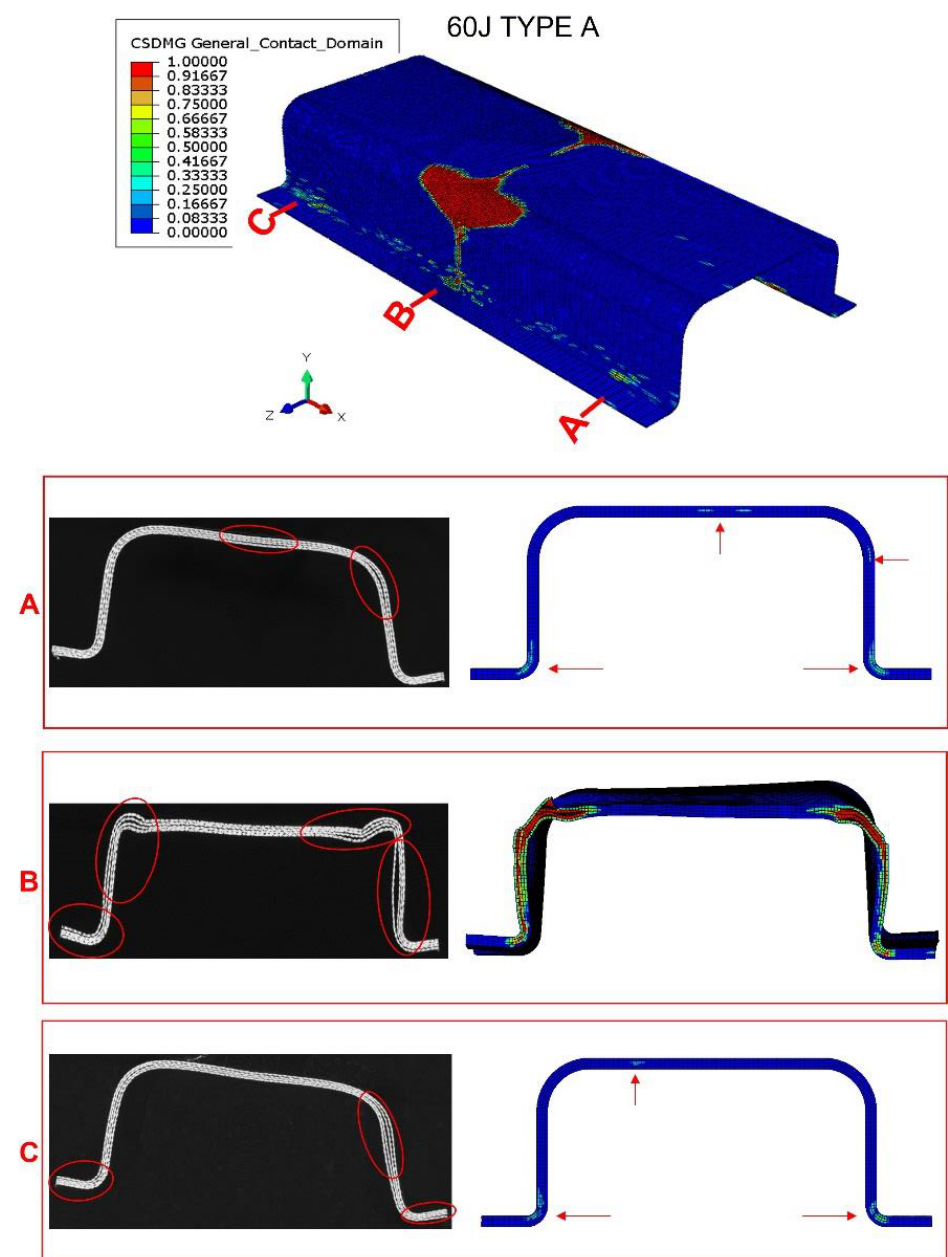
Figure 10. Tomography of bumper beam type A, impact energy of 60 J; comparison with numerical results. Observation of the interlaminar failure in the ends of the beam (sections A and C) and the center of impact (section B). The red arrows in the numerical screenshot point the appearance of failure in sections A and C.